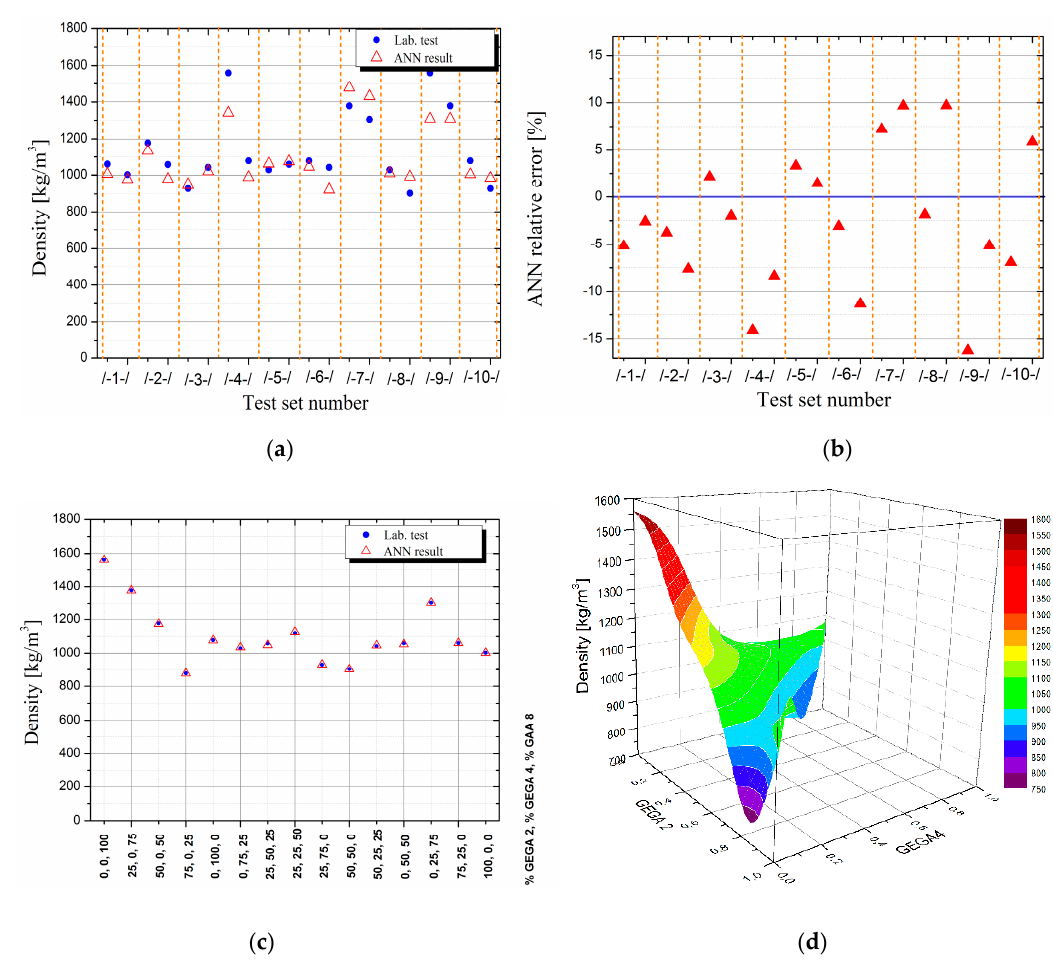
Figure 2. Illustration of results obtained using artificial neural networks (ANN) for density of lightweight concrete (LWC) as a function of GEGA 2 mm and GEGA 4 mm shares in the specimen, ( a ) results generated by ANN for individual testing datasets ( b ) relative error of ANN for individual testing datasets ( c ) comparison of measurement results with values obtained by ANN for training database ( d ) values of density of LWC predicted by ANN for intermediate points between measurement data from the training dataset.